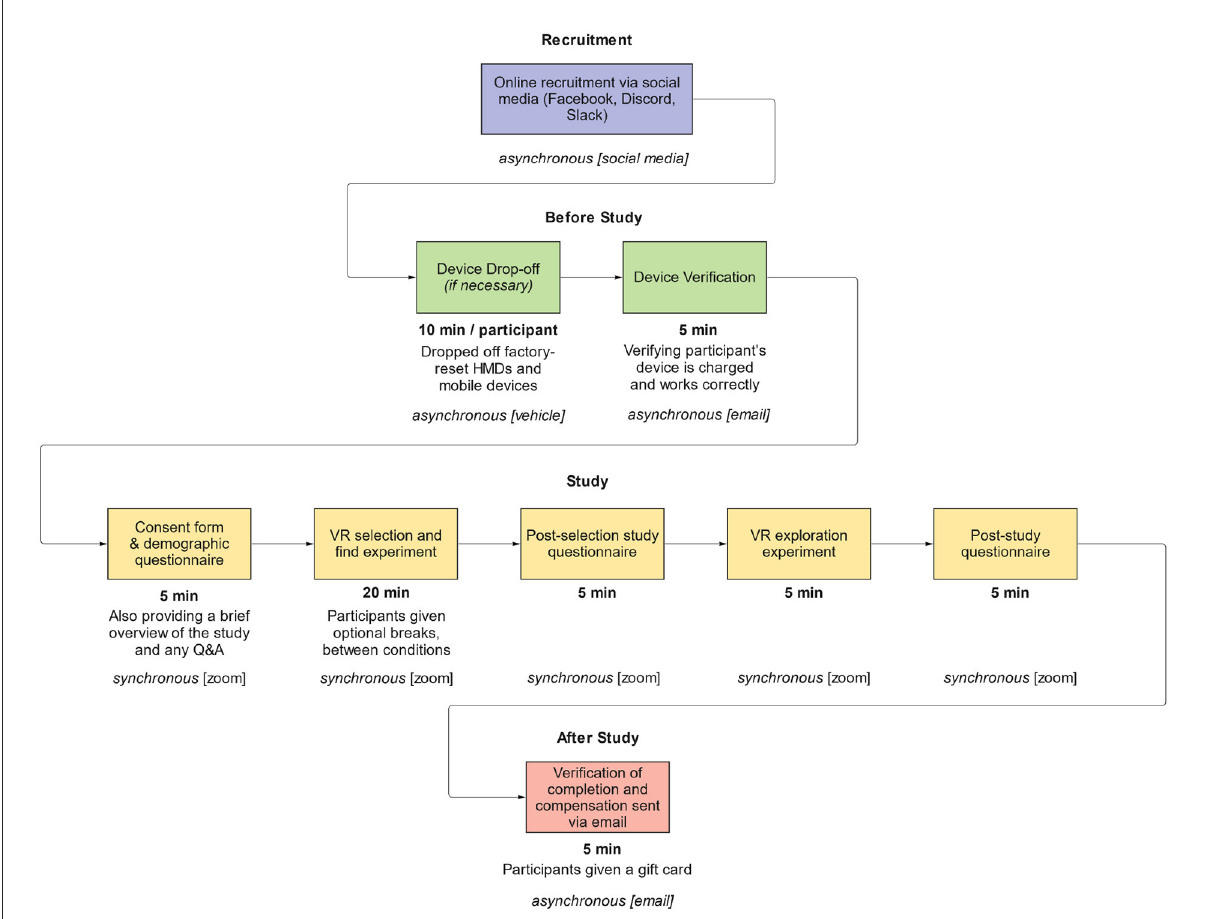
FIGURE2 Visualization of the study procedure for the multi-platform VR task performance study.